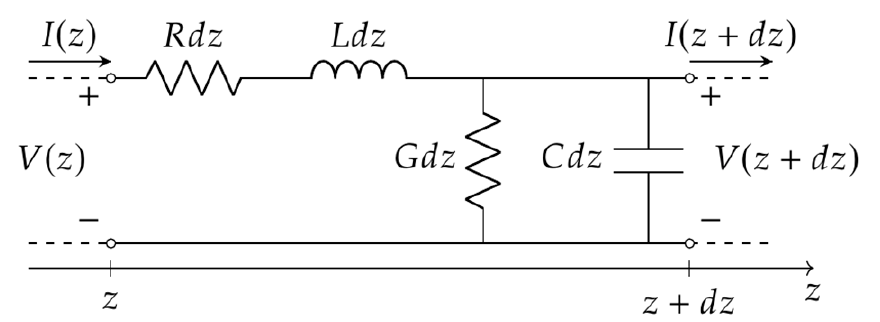
Figure 3. Elementary cell of a transmission line.